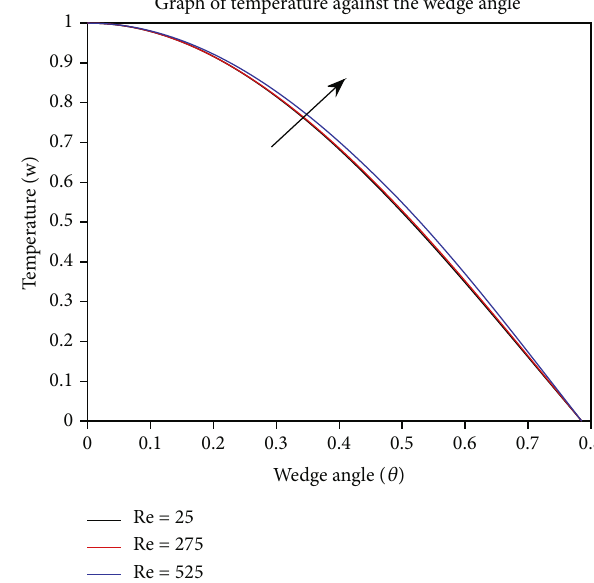
Figure 6: E ff ect of varying the Reynolds number on temperature.